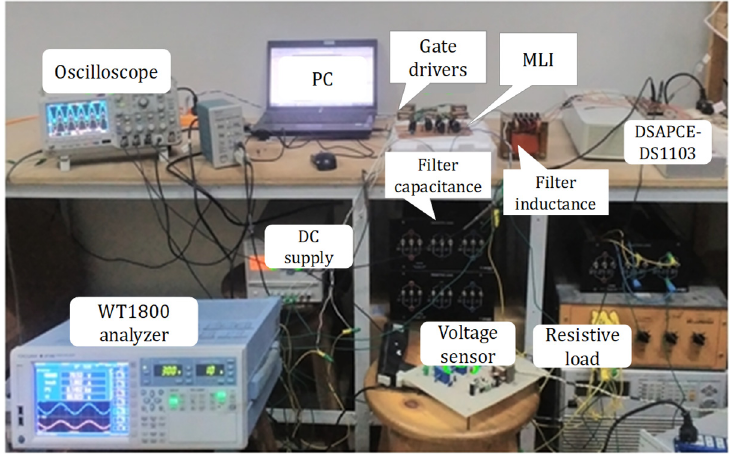
Table 5. Experimental system parameters.